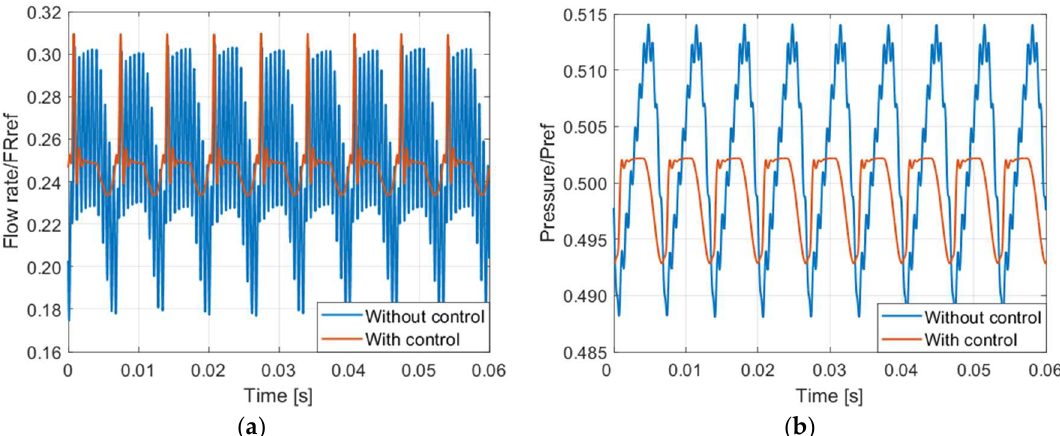
Figure 12. ( a ) Ideal model. Delivery mass flow rate. Shaft speed 1000 r/min; ( b ) Ideal model. Delivery pressure. Shaft speed 1000 r/min.